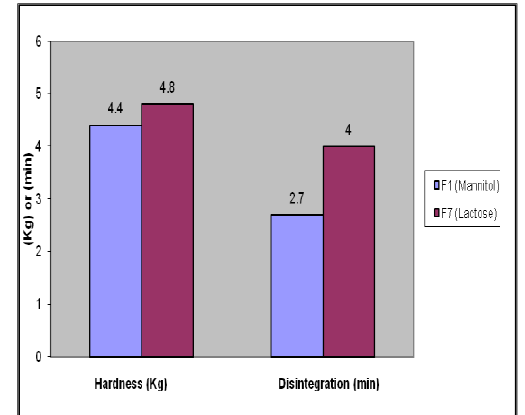
Figure 3: Effect of method of preparation on the hardness and disintegration time of formulas F5 (Direct method) and F6 (Wet method) of Bisoprolol tablets .